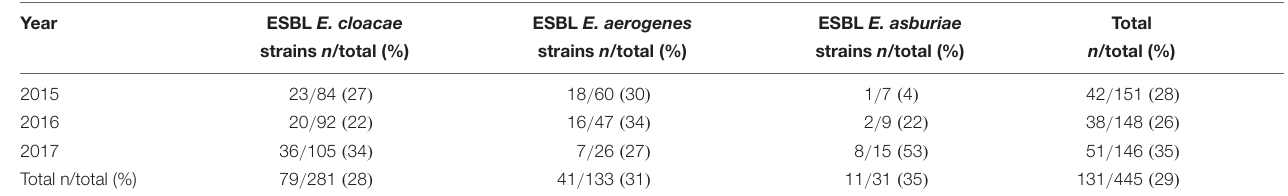
TABLE 3 | ESBL Enterobacter strains isolated from the year 2015 to the year 2017. Year ESBL E. cloacae ESBL E. aerogenes ESBL E. asburiae strains n /total (%) strains n /total (%) strains n /total